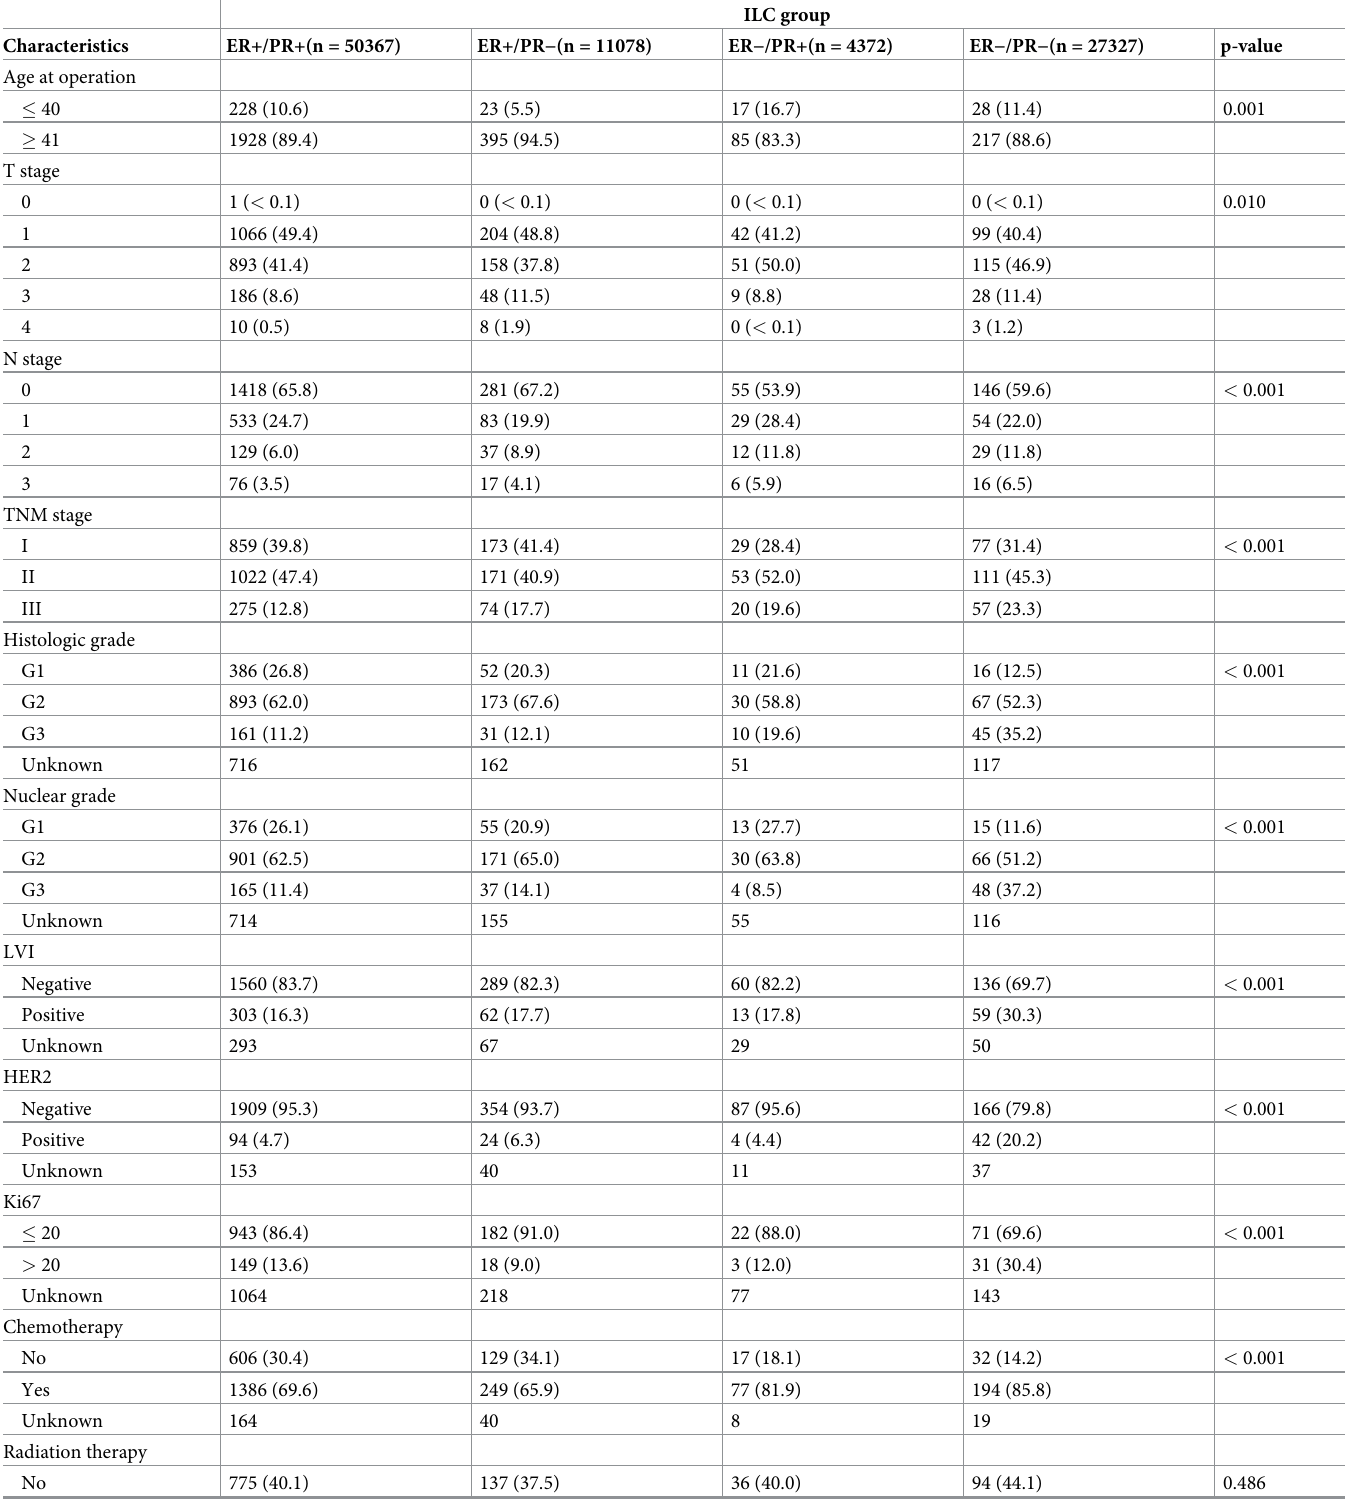
Table 2–2. Clinicopathological characteristics of hormonal expression subgroups in ILC